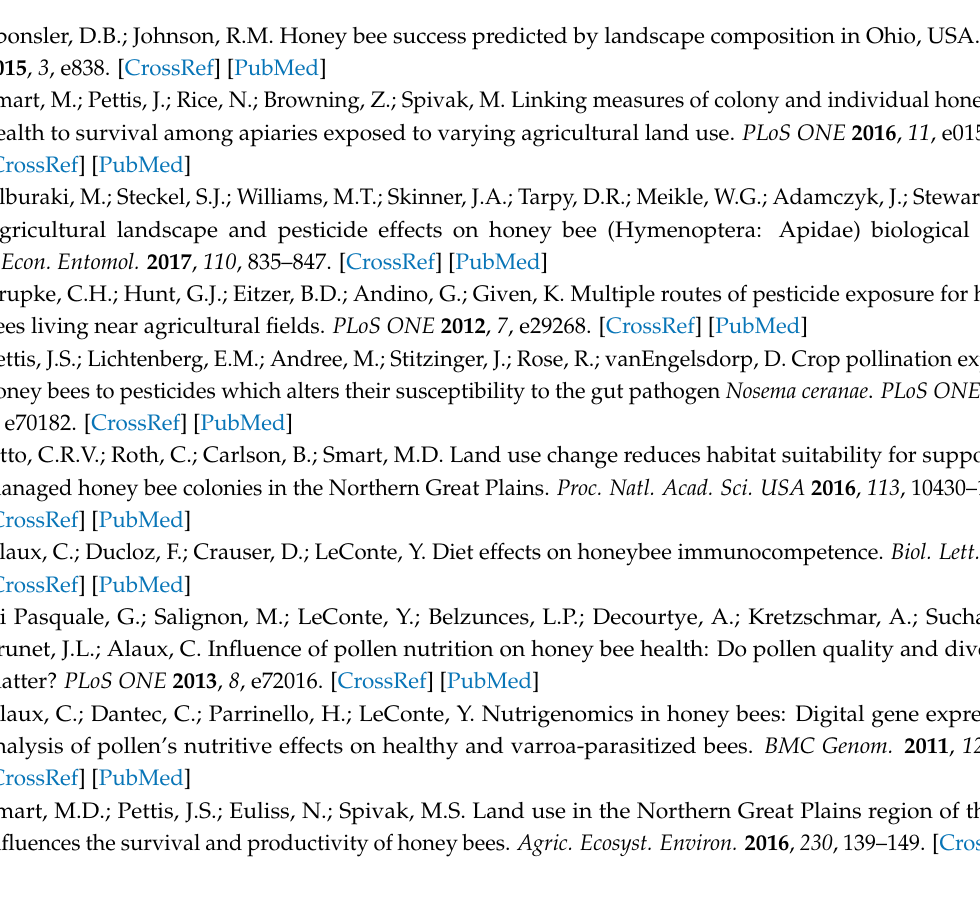
Table S1: Counts-per-million of all taxa with greater than 50 assigned reads by apiary and date, Table S2: Meta data for Table S1, Table S3: Pesticide residues (ppb) detected in honey bee-collected pollen, harvested from pollen traps by apiary and